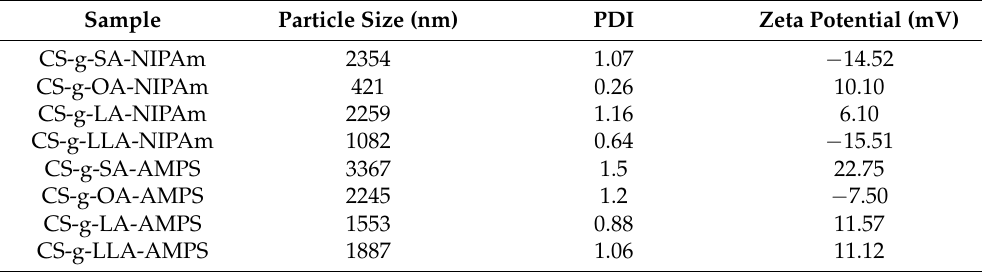
Table 1. Comparison of the data of particle size, PDI, and zeta potential for various CS-based modified samples.